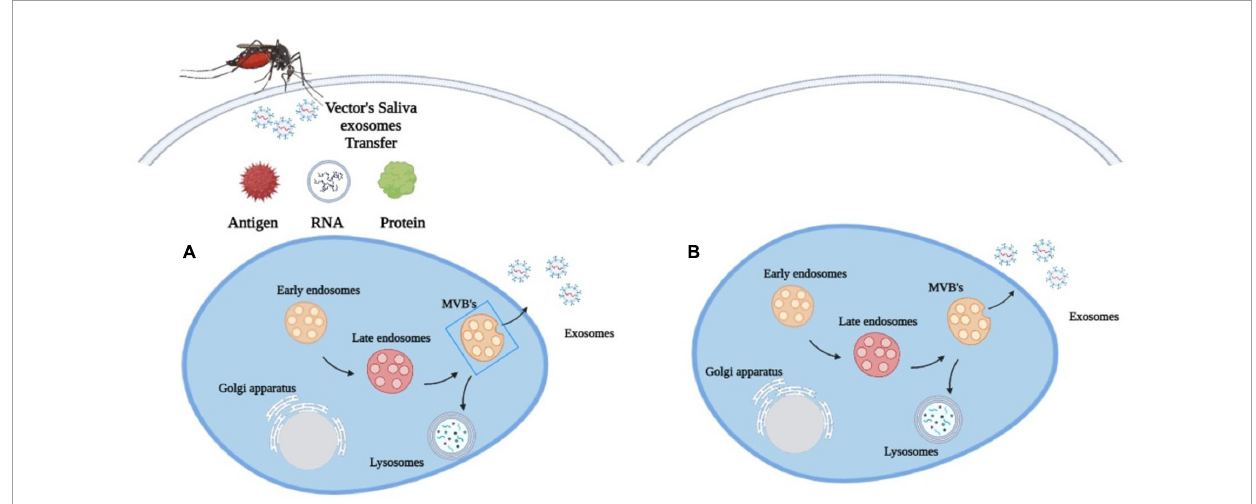
FIGURE2 Exosomes biogenesis in (A) vector-borne diseases. Arthropods release exosomes into the host blood circulation through their saliva, which transfer antigens, proteins and RNA to modulate immune responses, gene expression and metabolic processes and (B) in other diseases. Exosomes are released only by the diseased